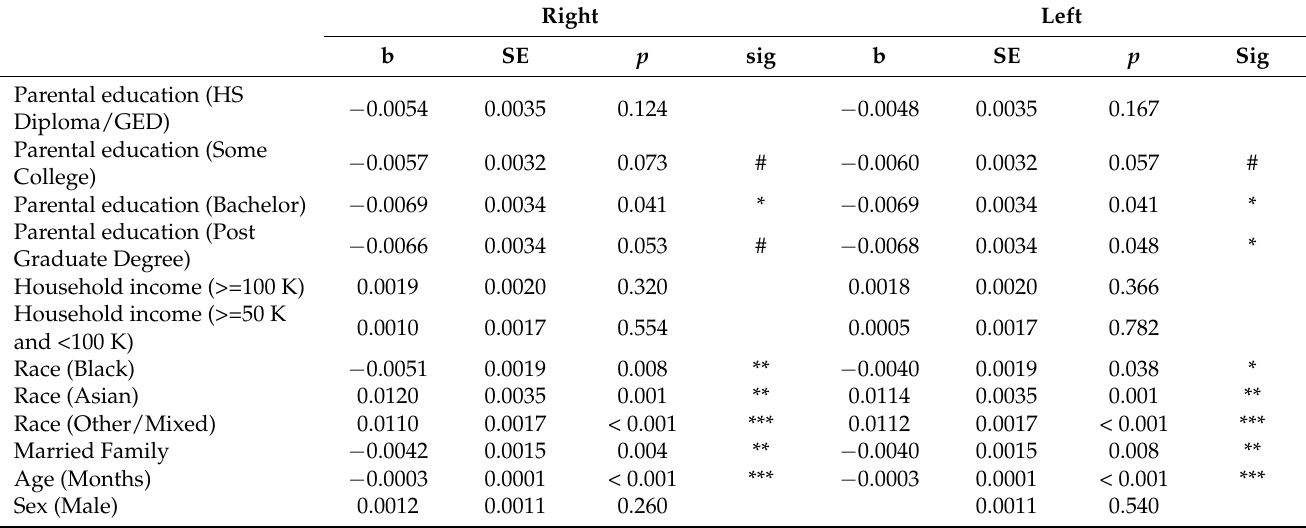
Table 3. Regressions in the overall sample and by race with right and left cerebellum cortex fractional anisotropy as the outcomes.